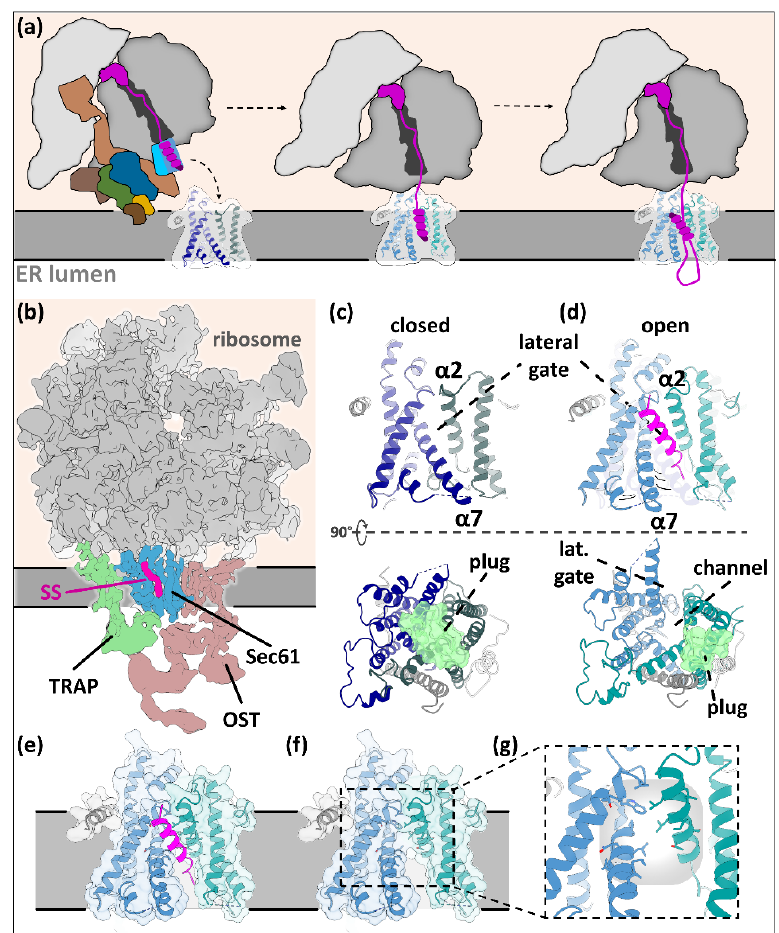
Figure 5. Co-translational ER translocation by Sec61 through the ER translocon. ( a ) Graphic description of co-translational ER insertion/translocation by the SRP-Sec61. The SP is handed over from SRP54-M and inserts head-on into primed Sec61, removing the plug, before rearranging in a hairpin with a N in -C out conformation. The SP is then accommodated at the lateral gate of Sec61. ( b ) Tomographic map of the translating ER translocon (EMDB-4315) [90]. TRAP is accommodated at the side of Sec61, its cytosolic portion interacting with the ribosome, its luminal portion close to the opening of the translocation channel. The oligosaccharyltransferase (OST) does not interact with SPs. ( c , d ) Open and closed conformations of Sec61, based on PDBs 3J7Q and 3JC2 [92,95]. Upon channel opening, the plug (green, seen from within the lumen facing the membrane) is removed and the vertical channel is opened. The lateral gate can now harbor the SS. ( e – g ) SP binding site at the lateral gate. The binding site is partially open to the ER lipid environment, partially formed by hydrophobic residues of helices α 2 and α 7.